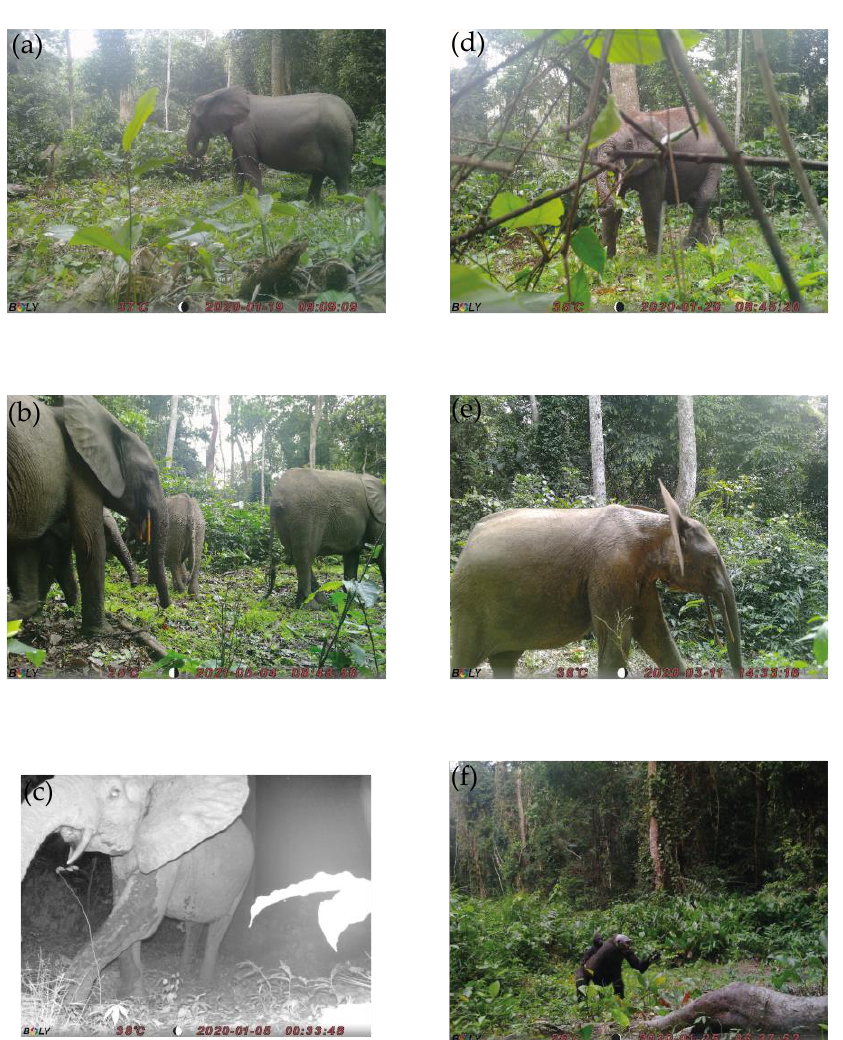
Figure 6. Consumers of C. gabunensis seedlings in plantations; ( a – e ): L. cyclotis ; ( f ): G. gorilla .